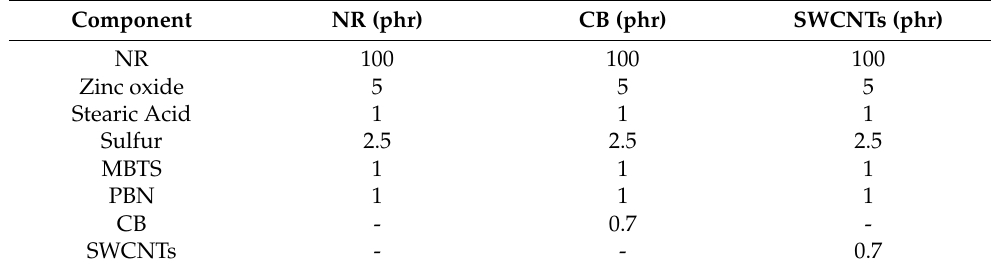
Table 2. Formulations used for sulfur vulcanized NR composites.